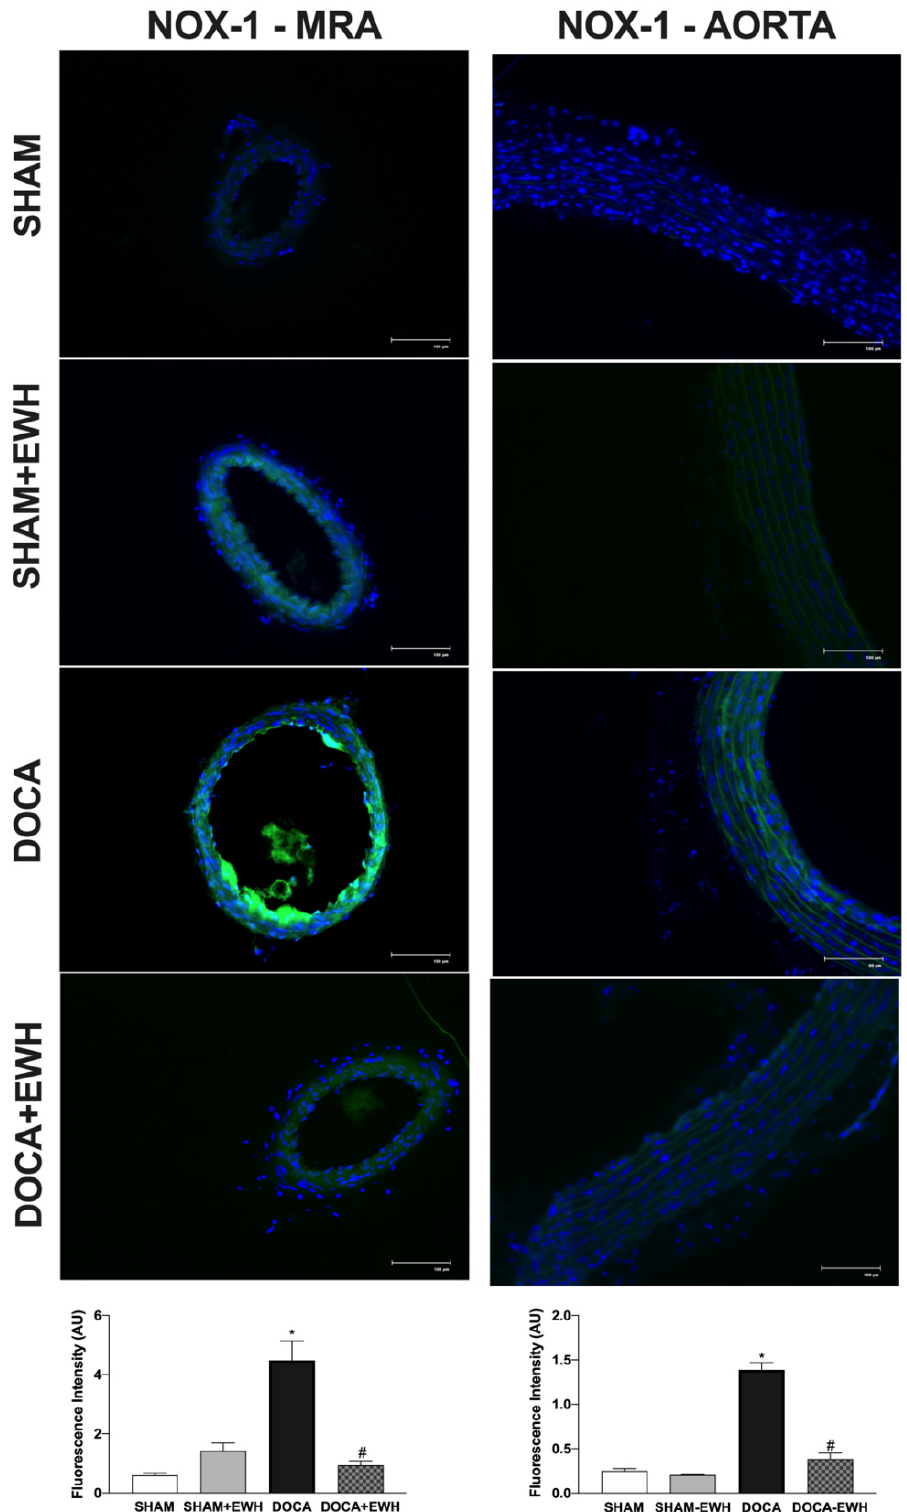
Figure 8. The role of EWH on NOX1 expression in MRA and aorta section of DOCA-salt rats. Representative photomicrographs ( × 40 magnification) and histogram of NOX1 immunofluorescence in MRA and aortic sections of SHAM, SHAM+EWH, DOCA, and DOCA+EWH arteries. Data are expressed as mean ± SEM, n = 8. The images correspond to the merge of the marking of the colors by the DAPI in blue and the NOX-1 in green. Two-way ANOVA followed by Bonferroni post-test: p < 0.05 * vs. SHAM; # vs. DOCA.